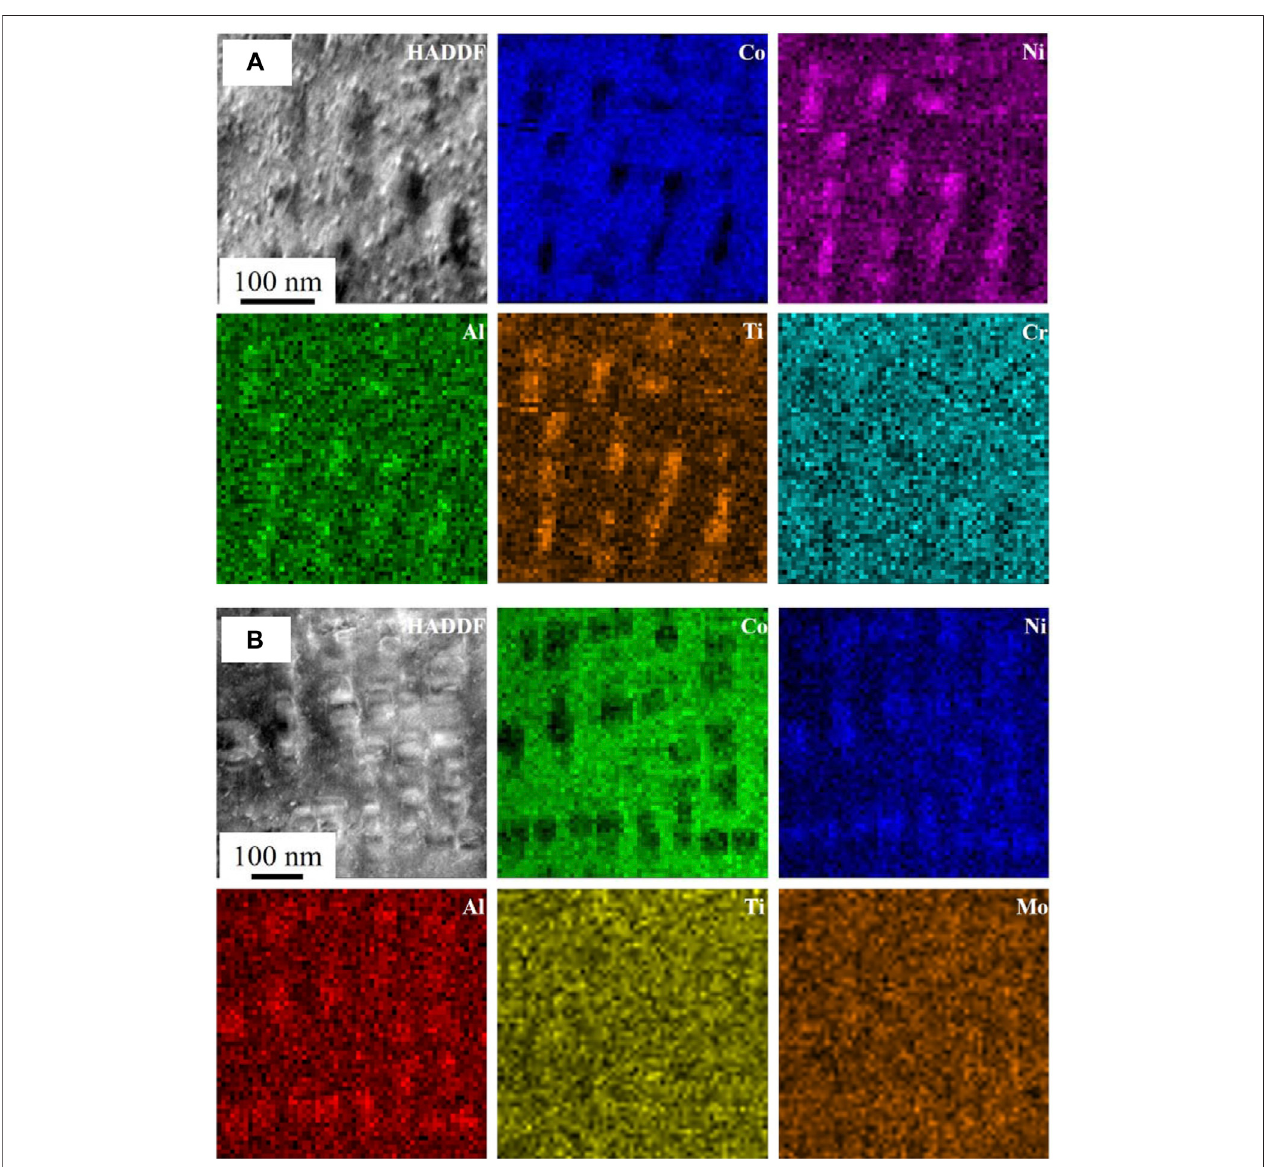
FIGURE 4| The high-angle annulardark fi eld (HAADF) images in the [1 0 0] zone axis and elemental mapping for the cuboidal precipitates using a TEM nanoprobe of superalloys aged at 1073 K for 32 h: (A) 2Cr, and (B) 2Mo.